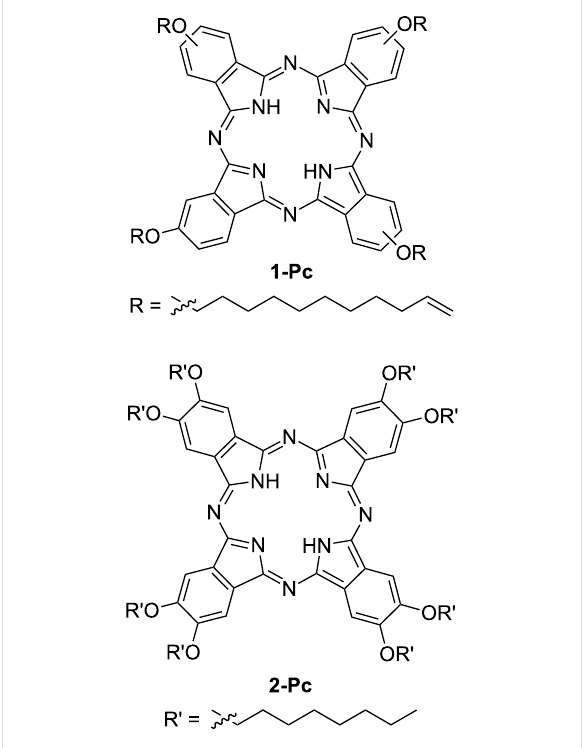
Figure 1: Chemical structures of 1-Pc and 2-Pc .